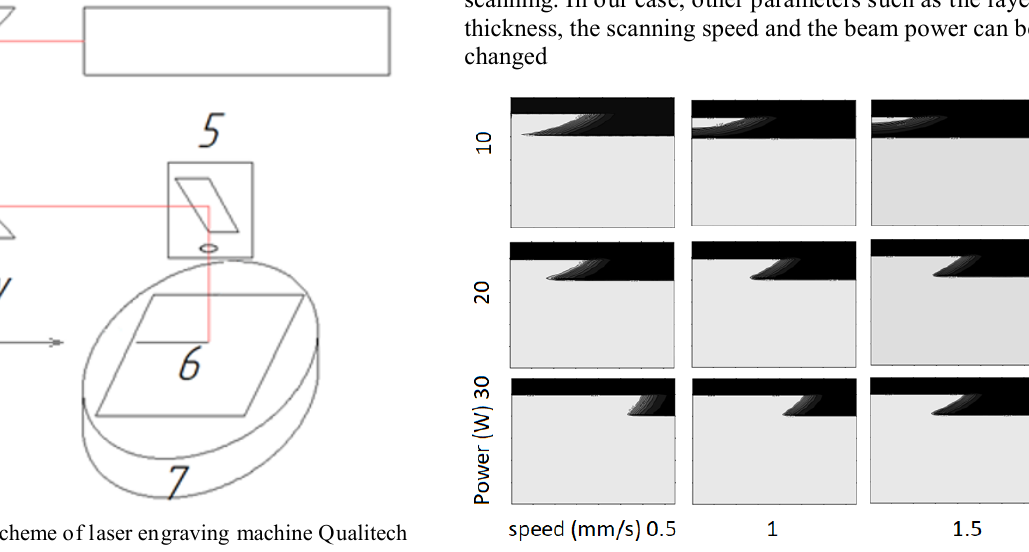
Fig. 6. Comparative results of modelling consolidation degree (white means ξ >0.9) of nine different situations with have different changing parameters: from top to bottom power changes from 10 to 30 W, from left to right scanning speed changes from 0.5 to 1.5 mm/s. Ambient temperature is 1100 K.